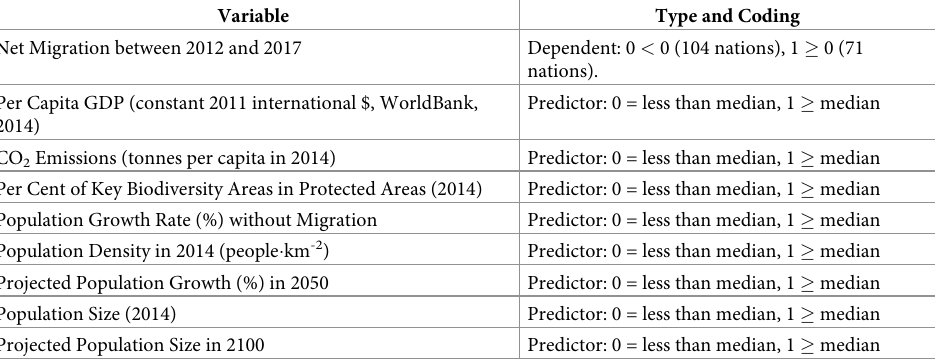
Table 1. List of national binary variables used to assess general patterns of human global migration.